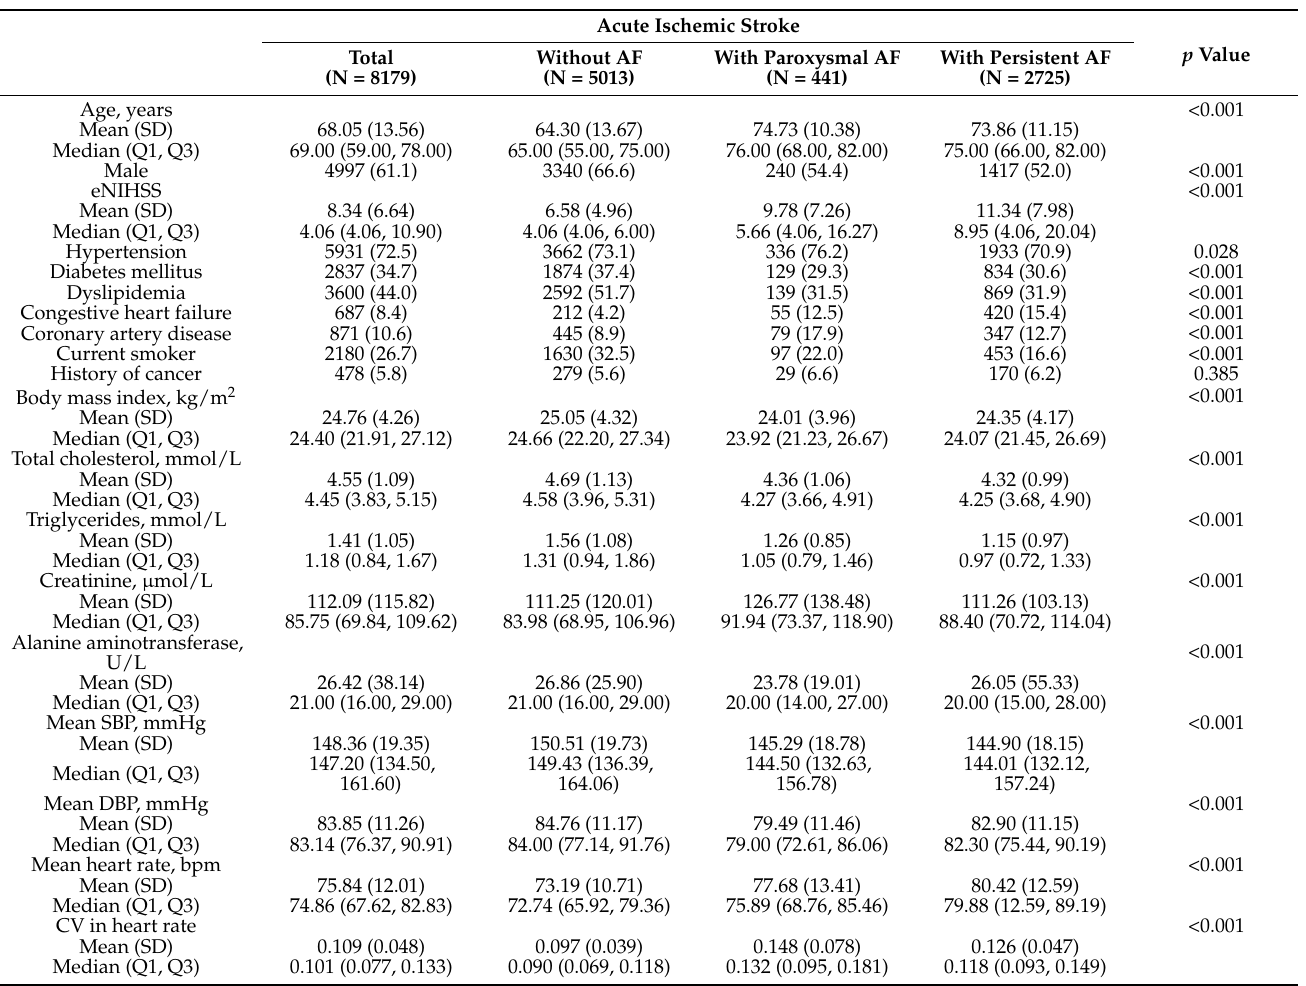
Table 1. Baseline characteristics of the study